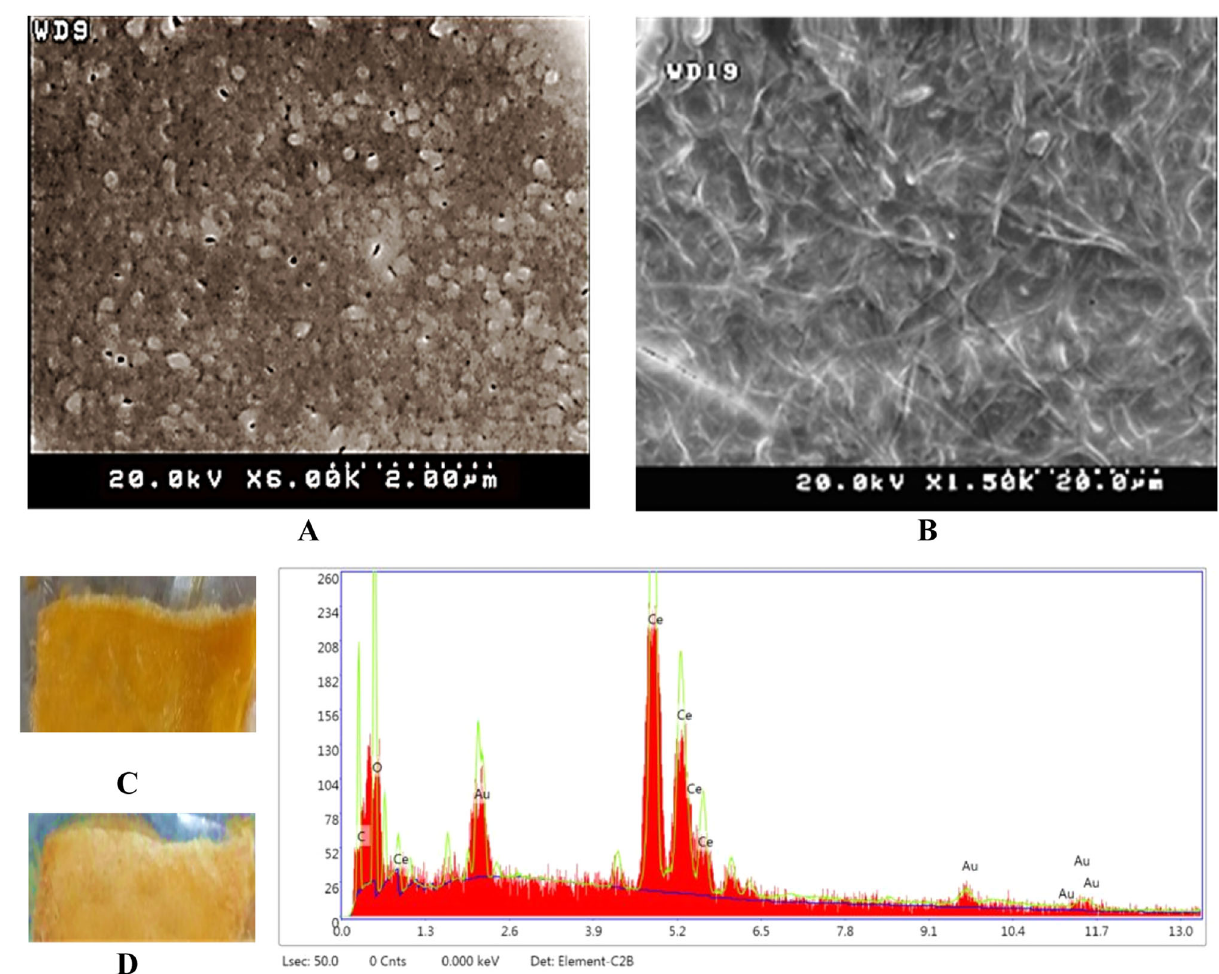
Fig. 1 Characterization of Scaffold-CeO 2 . A Electron microscopy image of CeONPs. B Scaffold-CeO 2 surface containing CeONPs. C Appearance of scaffold before electrospinning of